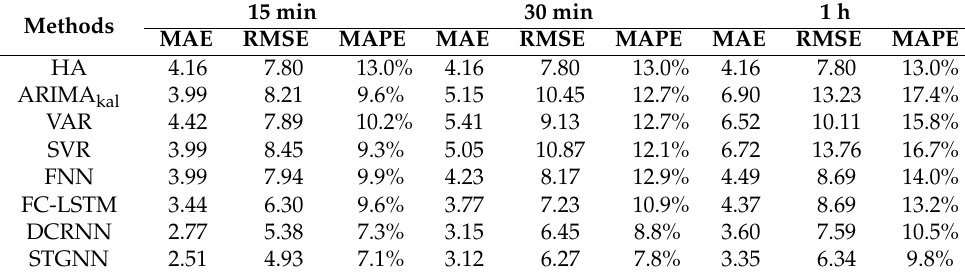
Table 1. Performance comparison of traffic speed prediction of multiple models on METR-LA dataset.